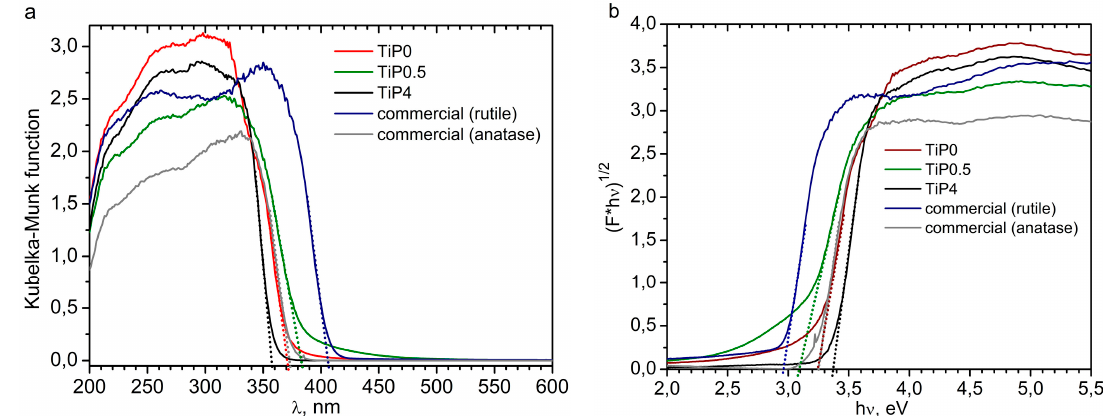
Figure 5. Kubelka-Munk function (F) vs. wavelength ( a ) and plot of (F·h ν ) 1/2 vs. h ν ( b ) for three pure phase samples: TiP0 (brookite), TiP1 (anatase), TiP4 ( Ti 2 O 2 H(PO 4 )[(NH 4 ) 2 PO 4 ] 2 ) and two commercially available samples: anatase and rutile.